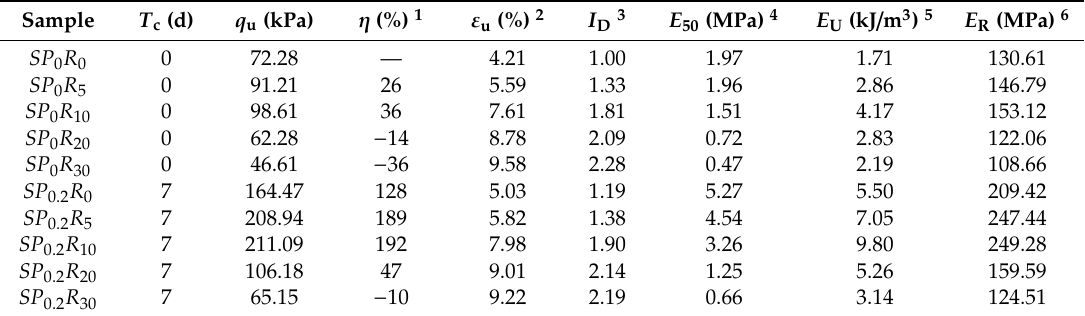
Table 8. Summary of the stress–strain features for the natural soil and various GR-blended samples— SP x R y where x = {0, 0.2}, and y = {0, 5, 10, 20, 30}. samples— SP x R y where x = {0, 0.2}, and y = {0, 5, 10, 20,